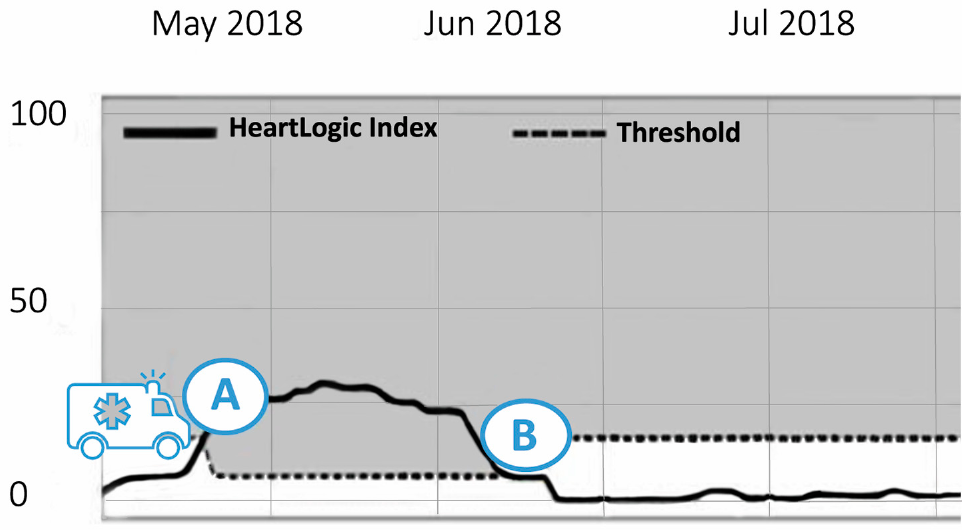
Figure 6. The course of HeartLogic TM index of patient described in Case 2. Ambulance (19 April): Presentation with a ventricular tachycardia. A (29 May): Phone contact. HeartLogic TM index exceeded the threshold of 16. B (12 June): Phone contact. HeartLogic TM index 0.